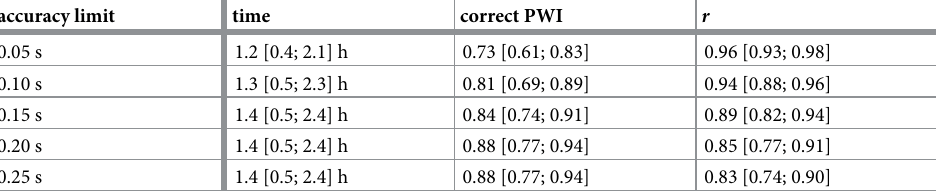
Table 2. PWI reconstruction correctness for different accuracy limits. Results are shown for five different maximally accepted differences between RRI and PWI (accuracy limits). The column “time” reports the median total duration of all PWI that are correctly associated with RRI (per subject). As in Table 1, it is followed by the fraction of correctly asso- ciated PWI and the corresponding Pearson cross correlation r . Values are median [0.25 quantile; 0.75